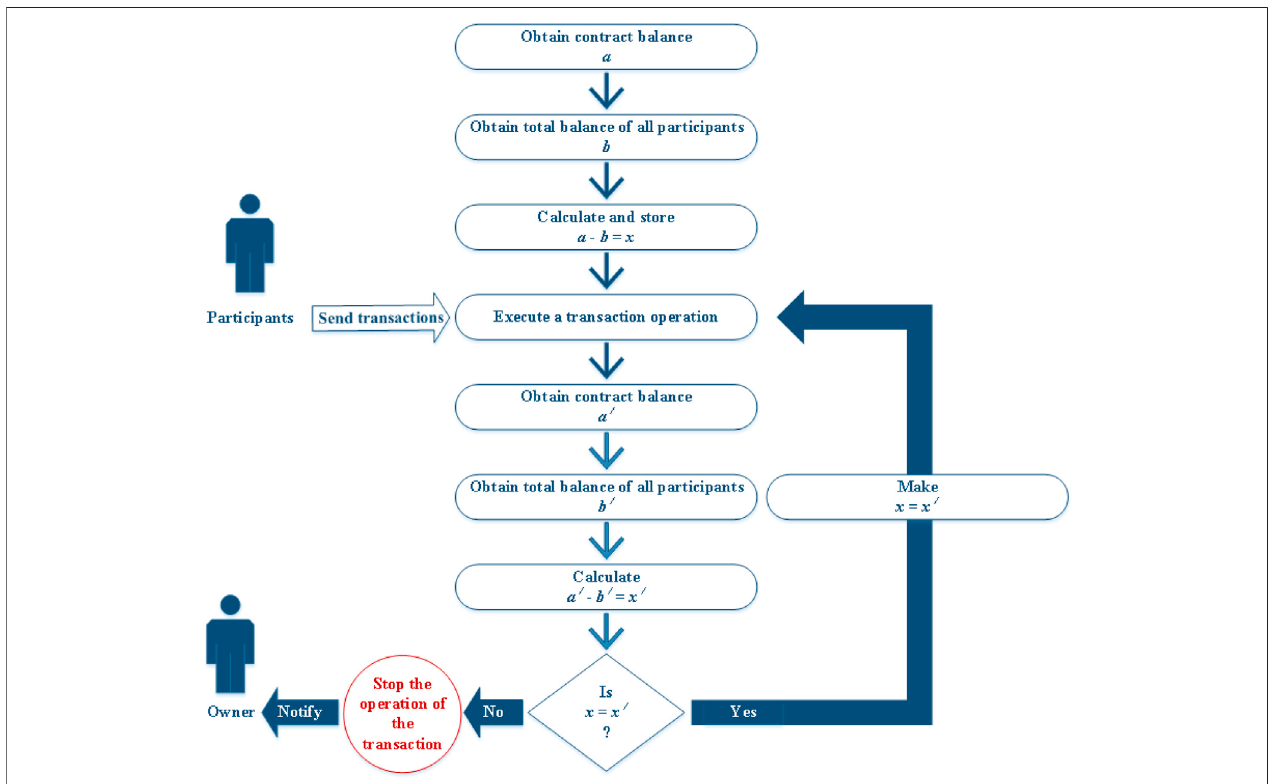
FiGURE 3 | The solution data fl ow.